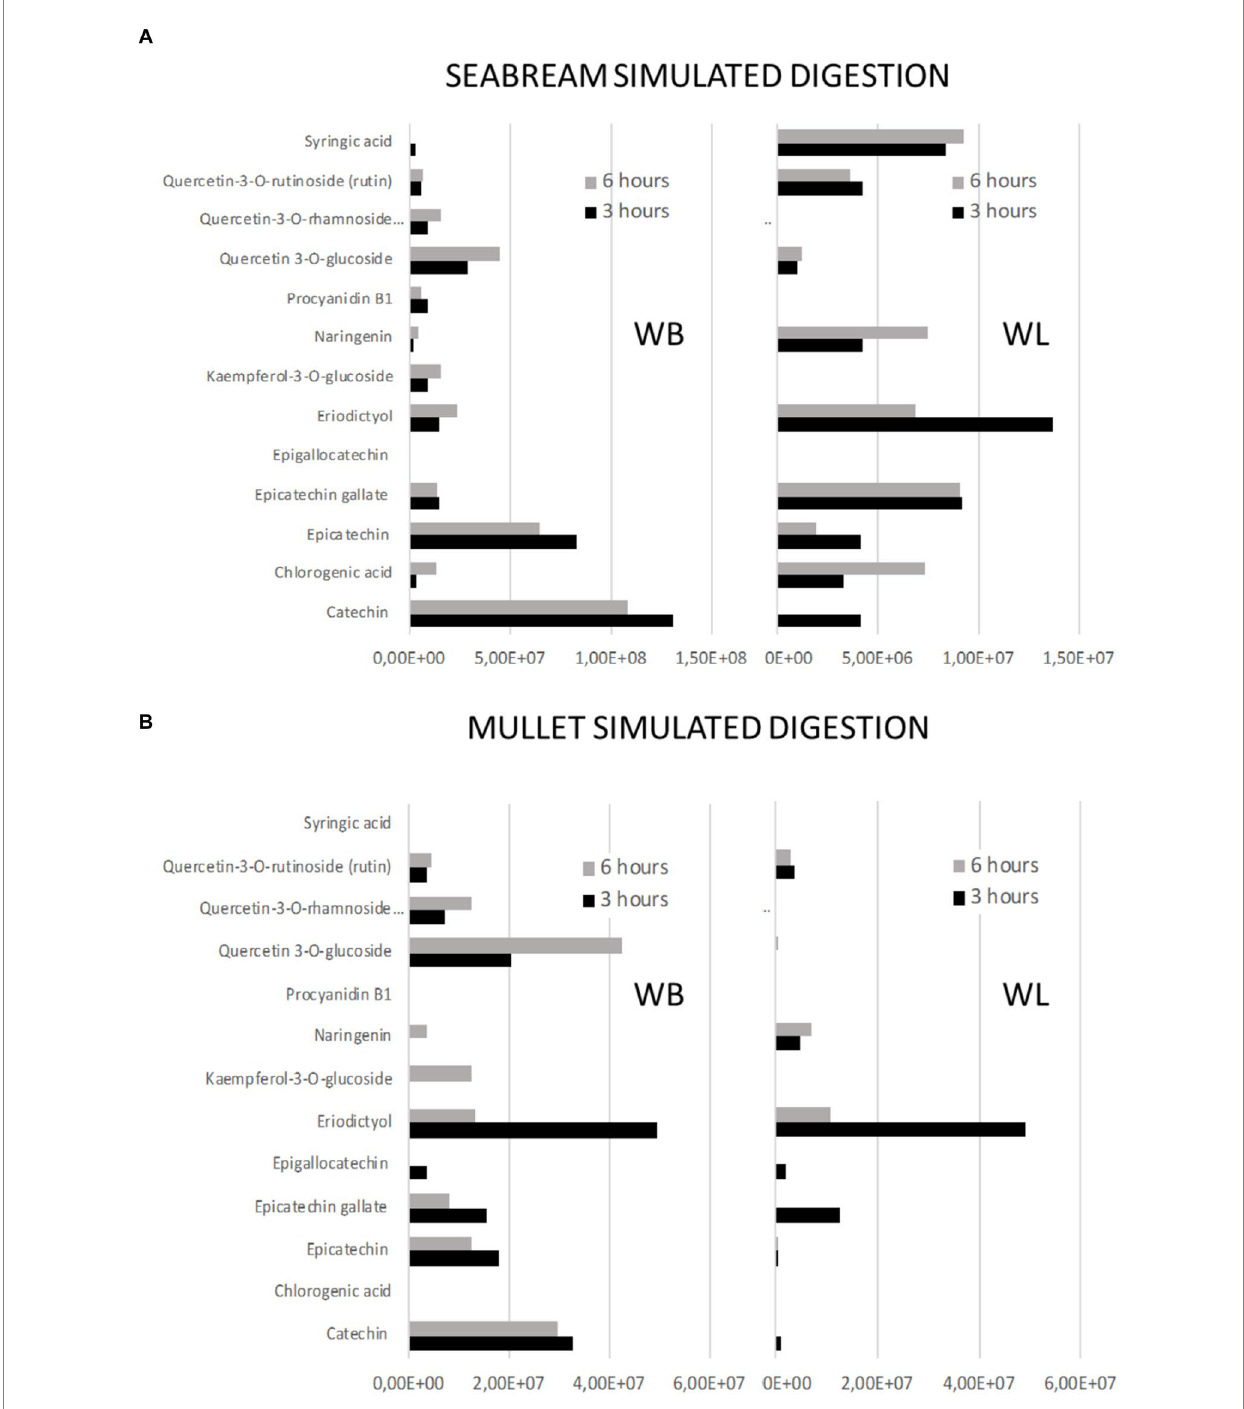
FIGURE 6 Profiles of release of phenolic compounds from either wine bagasse (WB) or lees (WL) measured at two different time moments (3 and 6 h) during simulated digestion of (A) seabream and (B) flathead mullet. Values are expressed as the sum of all peak areas